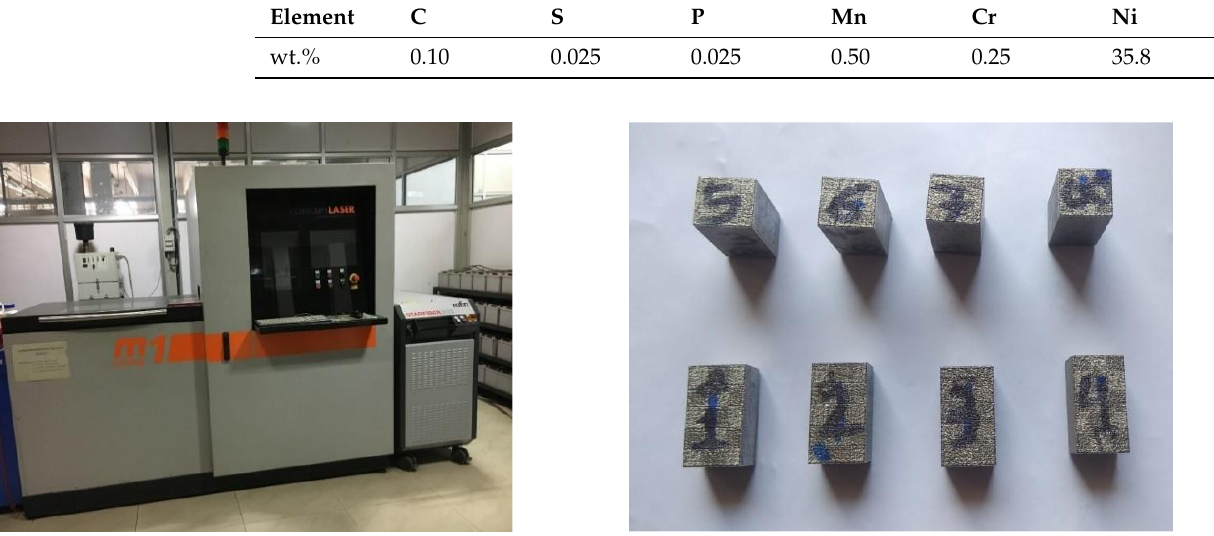
Figure 1. Powder-based fusion process machine.